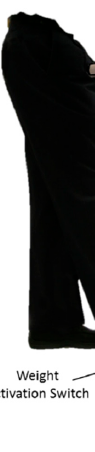
Figure 9. Illustration of the U-Step walking cane. The walking cane device projected a red laser line on the ground only when pressure was applied to the weight activation